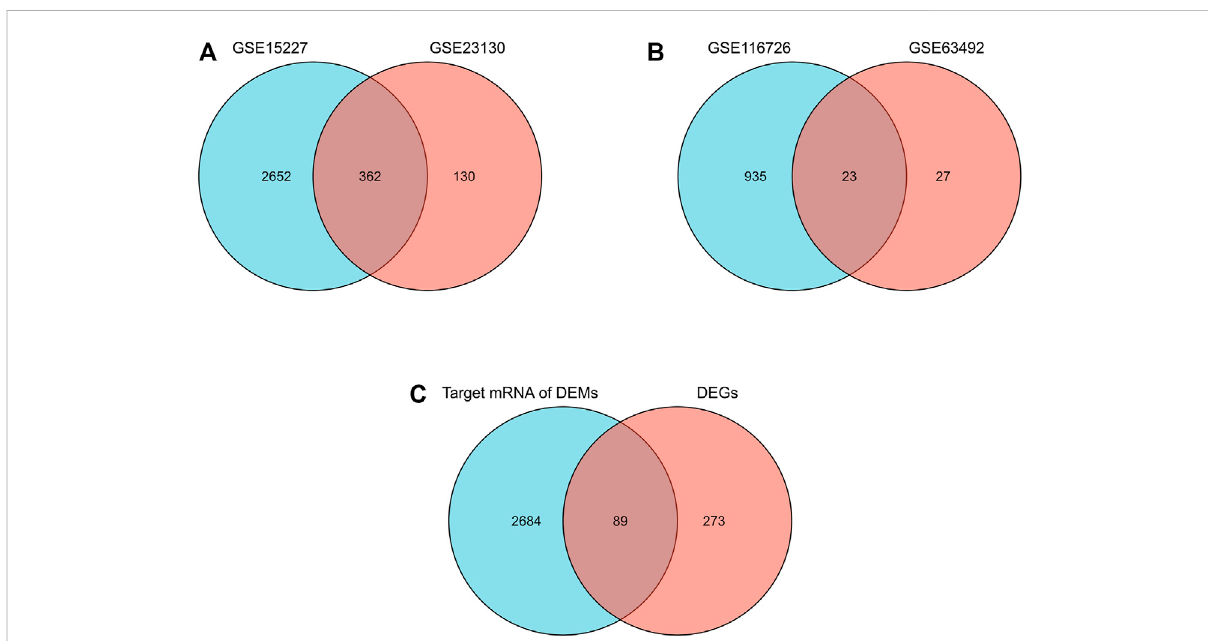
FIGURE 1 DifferentialexpressionofmRNAs,miRNAs,andhubgenesinIDD. (A) VenndiagramofdifferentiallyexpressedmRNAsinthetwomRNAdatasets. (B) Venn diagrams of differentially expressed miRNAs in two miRNA datasets. (C) Venn diagram of hub genes in IDD.